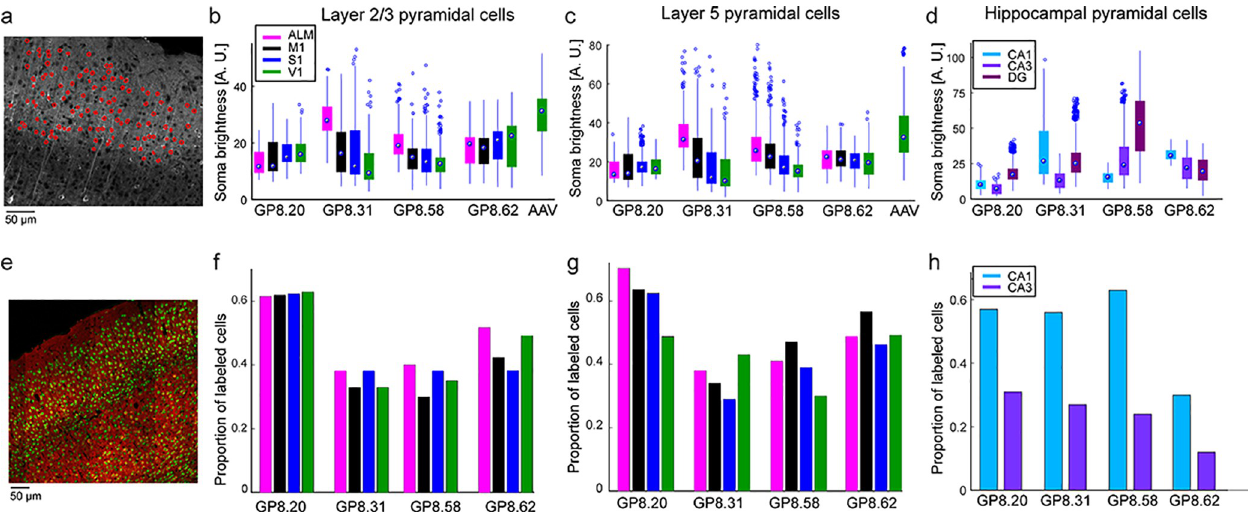
Fig 2. Quantification of jRGECO1a expression. a . Analysis method used for calculating the brightness of single neurons across brain regions. Confocal microscopy images of fixed brain slices were used for segmentation of cell bodies (red rings, nuclei were excluded). Somatic brightness was calculated by averaging all pixels in each segmented cell. b-d . somatic jRGECO1a brightness of labeled neurons in four GP lines and AAV infected mice. Each box indicates the 25 th to 75 th percentile distribution. Dots inside the boxes indicate the median, and whisker lengths correspond to the 150% of the 25 th to 75 th percentile distance, or until it touches the last sample position; outliers are marked by dots beyond the whisker range. Colors correspond to brain regions. b , Layer 2/3 pyramidal cells (sections from 3–7 mice per line; median, 6; 266–841 cells per brain region; median,684). c, Layer 5 pyramidal cells (same number of sections like in b ; 255–588 cells per brain region; median, 402). d , Hippocampal pyramidal cells (sections from 4–6 mice per line; median, 5. 80–913 cells per brain region; median, 303). e . Confocal image of GP8.31 fixed tissue (red) counterstained with NeuN (green). f-h . Proportion of neurons that are jRGECO1a- positive, estimated by counterstaining with NeuN, corresponding to b-d , respectively. (sections from 1 mouse per line; 84–298 cells, median, 160). DG labeling density was high but was not quantified (Results). ALM–anterior-lateral area of the motor cortex, M1 –primary motor cortex, S1 –primary somatosensory cortex, V1 –primary visual cortex, DG–dentate gyrus, CA1, CA3 –areas of the hippocampus.